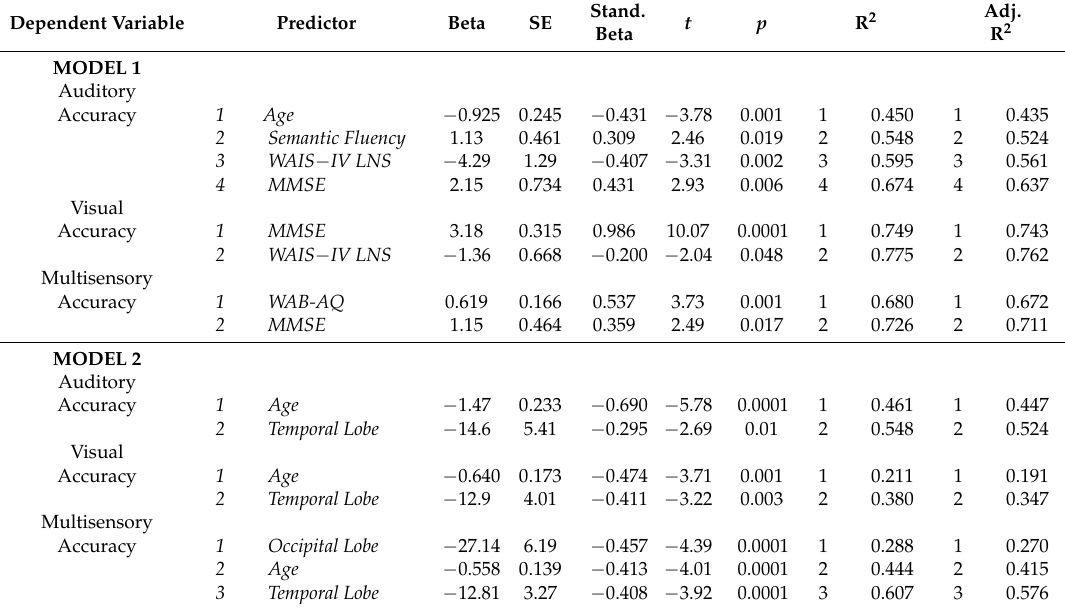
Table 6. Stepwise multiple regression results of predictors of naming accuracy.